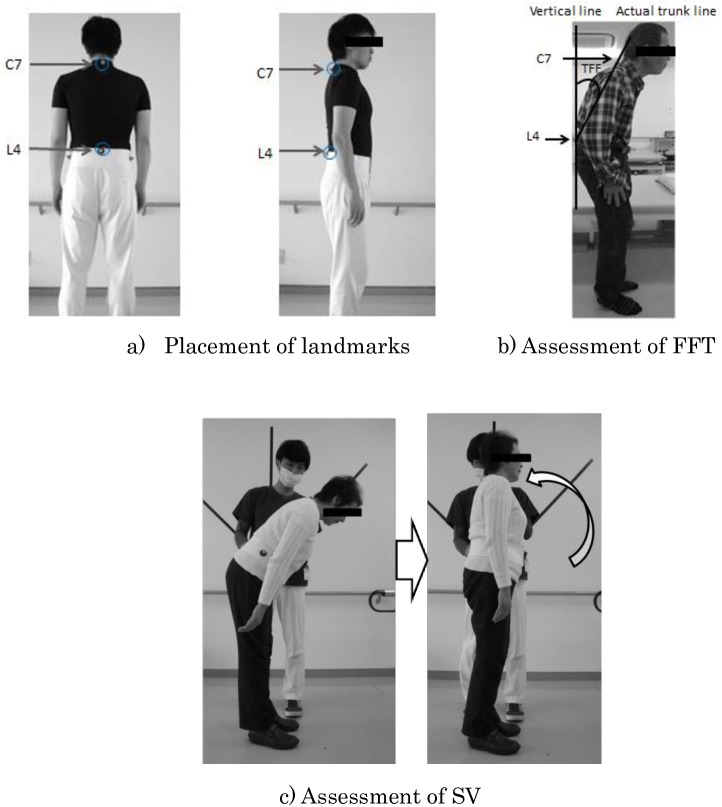
Method of assessing posture.a) Placement of landmarks. b) Assessment of FFT. c) Assessment of SV. C7: 7th cervical vertebra. L4: 4th lumbar vertebra. Vertical line: vertical line to the floor through L4. Actual trunk line: line connecting C7 and L4. FFT: forward flexion of trunk. Angle between the vertical line and actual trunk line. SV: subjective vertical position. Measurement of angle between subjective vertical position and objective vertical position of subjects. The starting position was a closed-eyes standing position in a position of 45° forward flexion. Extension from the 45° forward flexion position to a vertical position was passively induced at a speed of about 5 s, and the subject reported to the examiner the point in time that they recognized as vertical. Measurements were performed three times, and the mean of those three measurements was taken as SV.